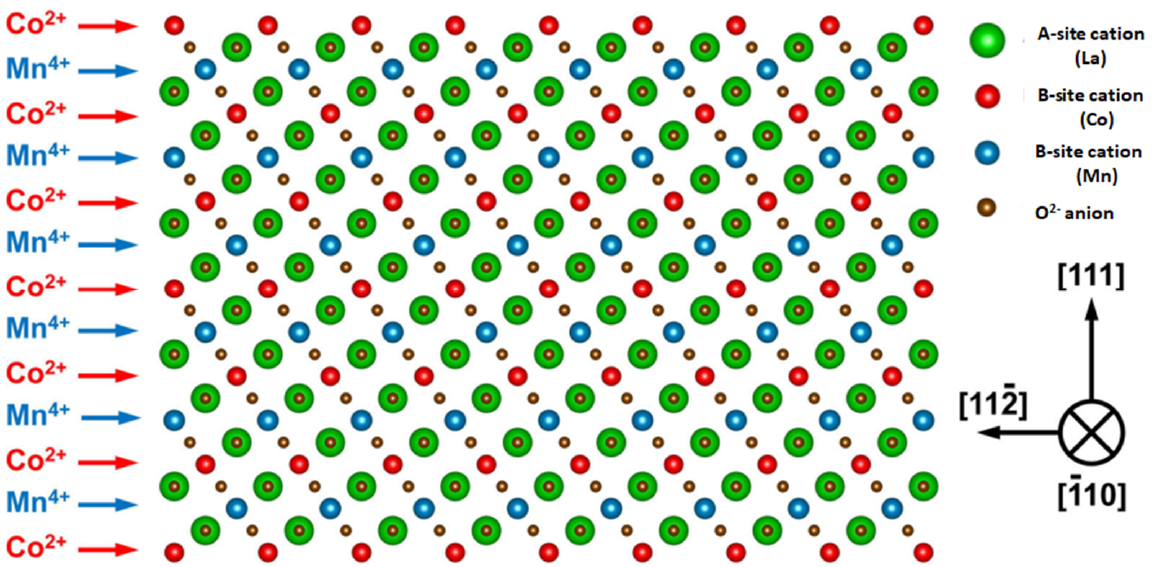
Figure 2. Lattice superstructure composed of LaMnO 3 and LaCoO 3 perovskite atomic planes formed along the [111]-direction in a fully ordered La 2 CoMnO 6 double perovskite (Vesta, [18]).